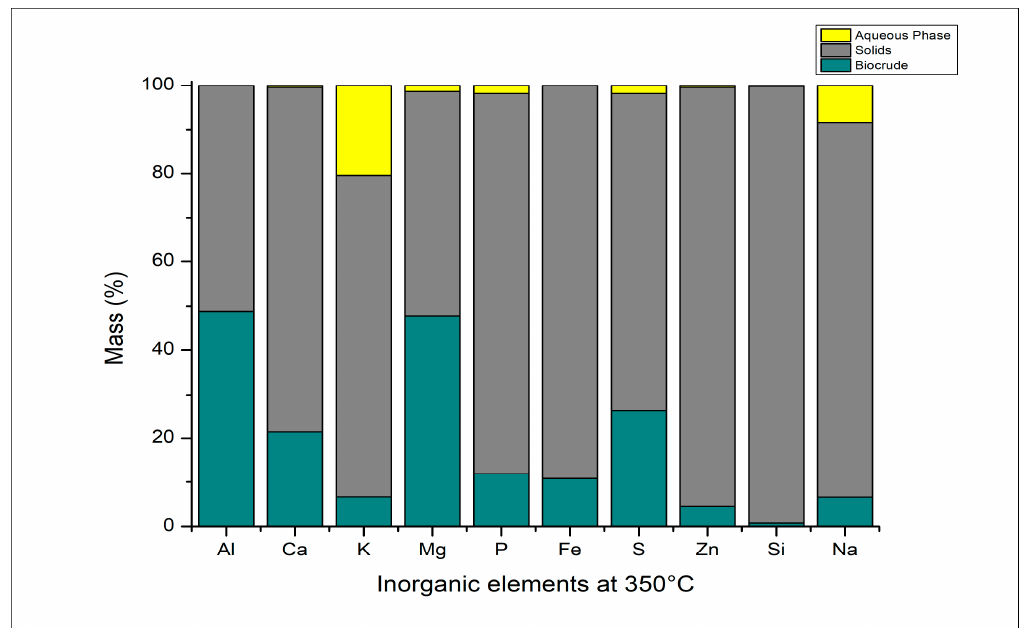
Figure 6. Mass distribution of inorganic elements at 350 °C.